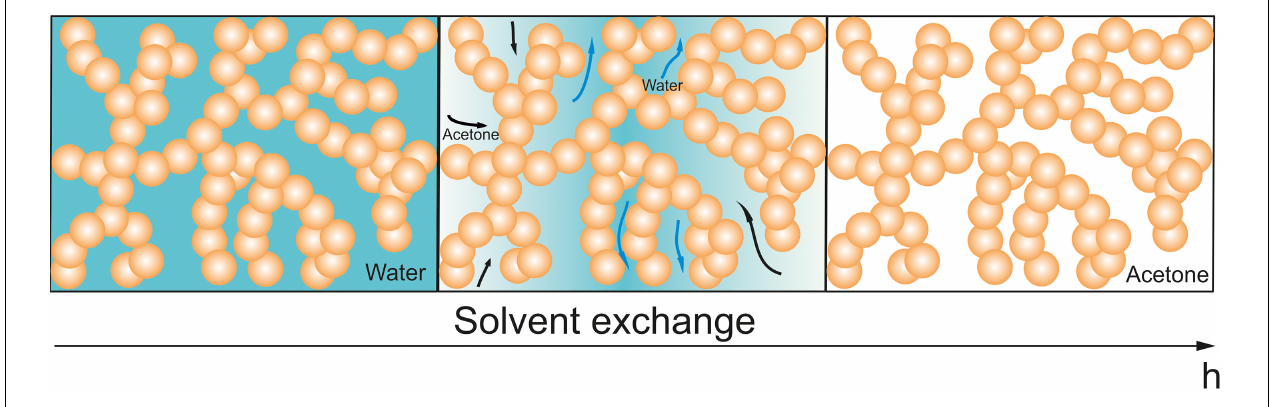
FIGURE 1 | Scheme of solvent exchange of RF aerogels. Left: After sol-gel process, the pores are filled with water and unreacted chemicals. Middle: During solvent exchange, water inside of the pores is replaced by acetone. Right: Finally, only acetone is present in the